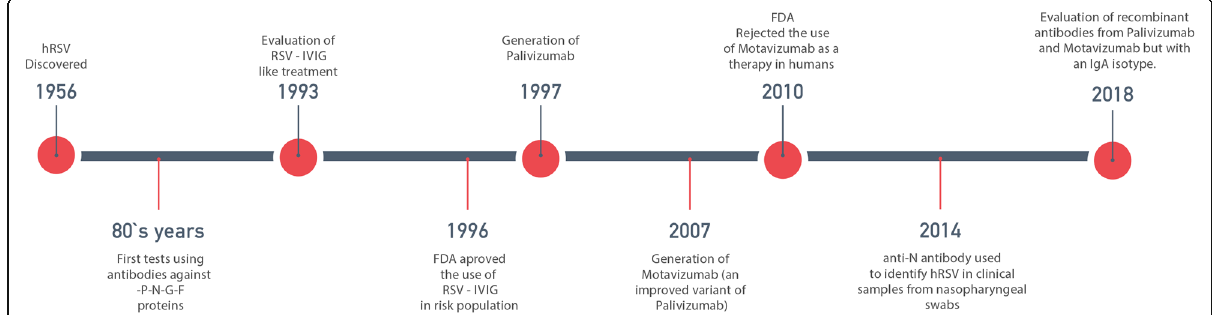
Fig. 1 Timeline of antibodies therapies since the discovery of hRSV as human pathogen. Advances and implementation of different strategies that use antibodies to promote the clearance of hRSV since the virus was first discovered in